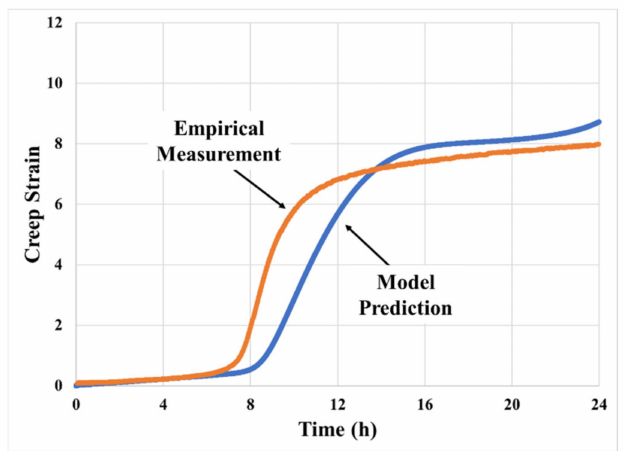
Figure 13. Empirical result vs. model prediction with identical parameters at a stress level of 50 kPa at 70 ◦ C.